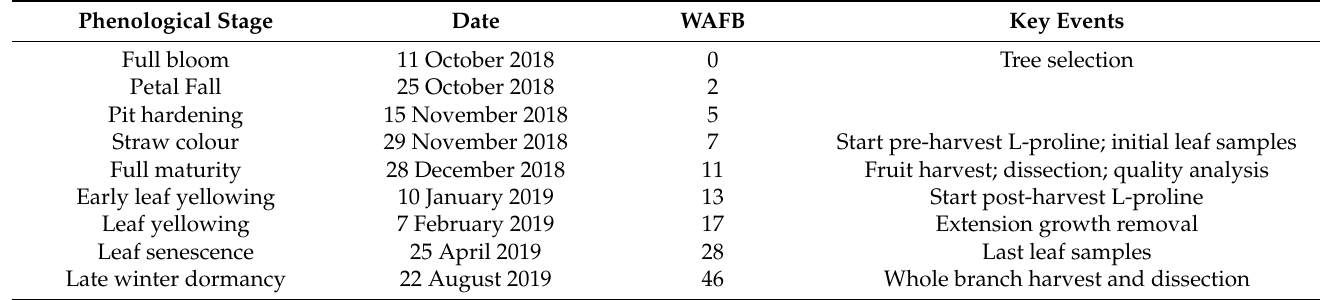
Table 1. Phenological stages and key events over the duration of the trial, related to weeks after full bloom (WAFB). Leaf samples were taken at intervals of three weeks, commencing at 7 WAFB and concluding at senescence at 28